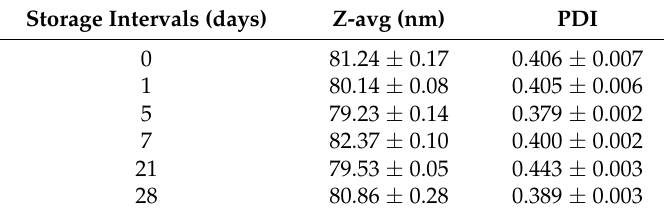
Table 4. Results of long-term stability analysis of liquid baicalin loaded liquid self-nanoemulsifying drug delivery systems (BSNEDDS) formula. (Mean ± SD; n =